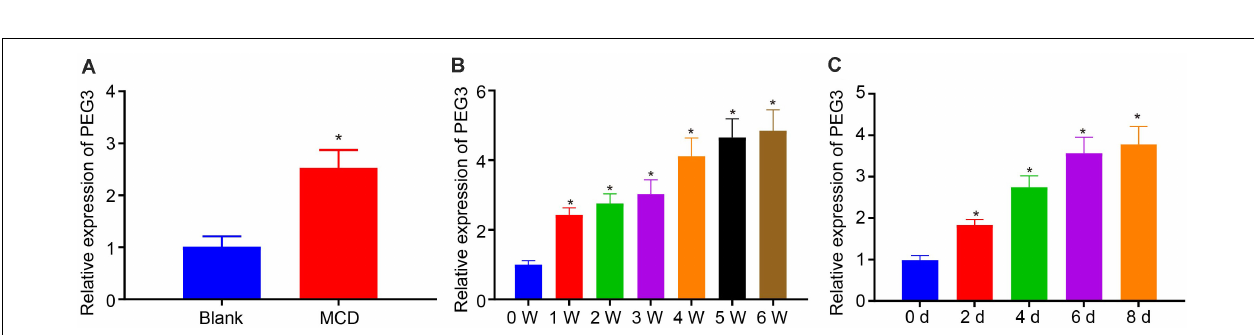
FIGURE 3 | PEG3 expression is upregulated in liver fibrosis of NASH. (A) Relative expression of PEG3 in liver tissues of mice on normal and 5-week MCD diets. (B) Relative expression of PEG3 in HSCs at different time points of mice on MCD diet from weeks 0 to 6. (C) Relative expression of PEG3 in HSCs at different time points of mice on normal diet from days 0 to 8. * p < 0.05 vs. the blank group (mice on normal diet) or the MCD group (mice on MCD diet) at 0 week or the blank group (mice on normal diet) on day 0. All data were measurement data and expressed as mean ± standard deviation. Comparison between two groups was analyzed using independent sample t -test. One-way analysis of variance was used for data comparison among multiple groups. The experiment was independently repeated three times. N = 6. HSCs, hepatic stellate cells.